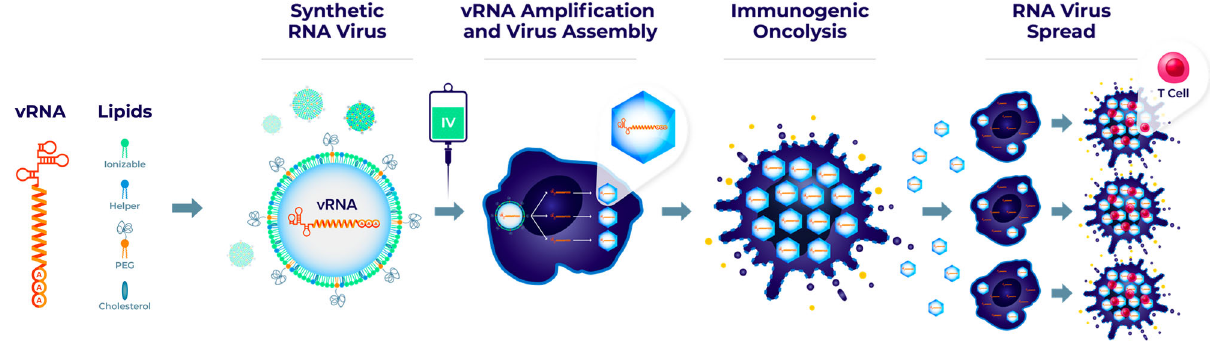
Fig. 1 | Schematic illustration of the mechanism of action of Synthetic RNA virus. SyntheticRNAvirusiscomprisedofIVT-producedvRNAencapsulatedwithin anLNP. Inside tumor cells, vRNA recapitulates all phases of the viral life cycle such